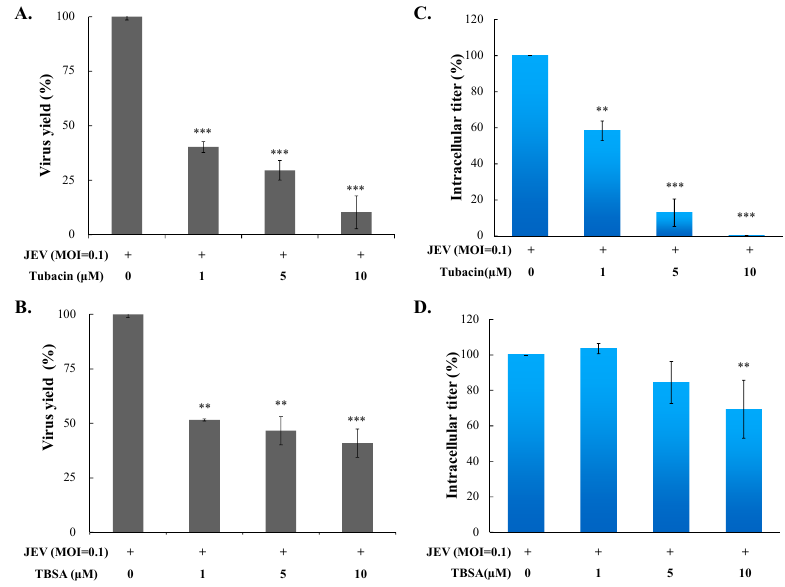
Figure 3. Suppression of virus yield and intracellular virion production by tubacin and TBSA. Cells were infected with JEV and immediately treated with indicated concentration of tubacin and TBSA. Virus yield in supernatant from infected cells treated with or without tubacin ( A ) and TBSA ( B ) was measured by plaque assay 36 h post infection. In intracellular virion production assay, the infected cells treated with or without tubacin ( C ) and TBSA ( D ) were lysed by three freeze-thaw cycles. The titer of intracellular infectious particles was determined by plaque assay. ** p value < 0.01; *** p value < 0.001 compared with untreated infected cells.